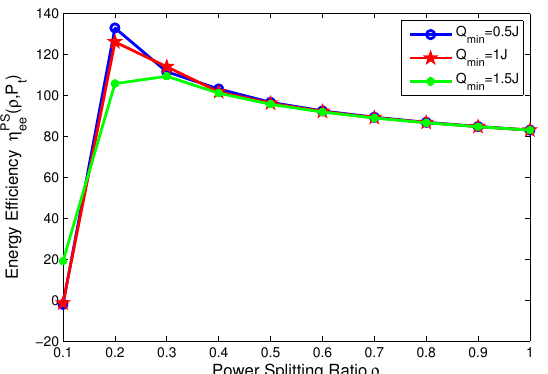
Figure 12. Energy efficiency versus power splitting ratio with different minimum harvested energy requirements for PS mode.